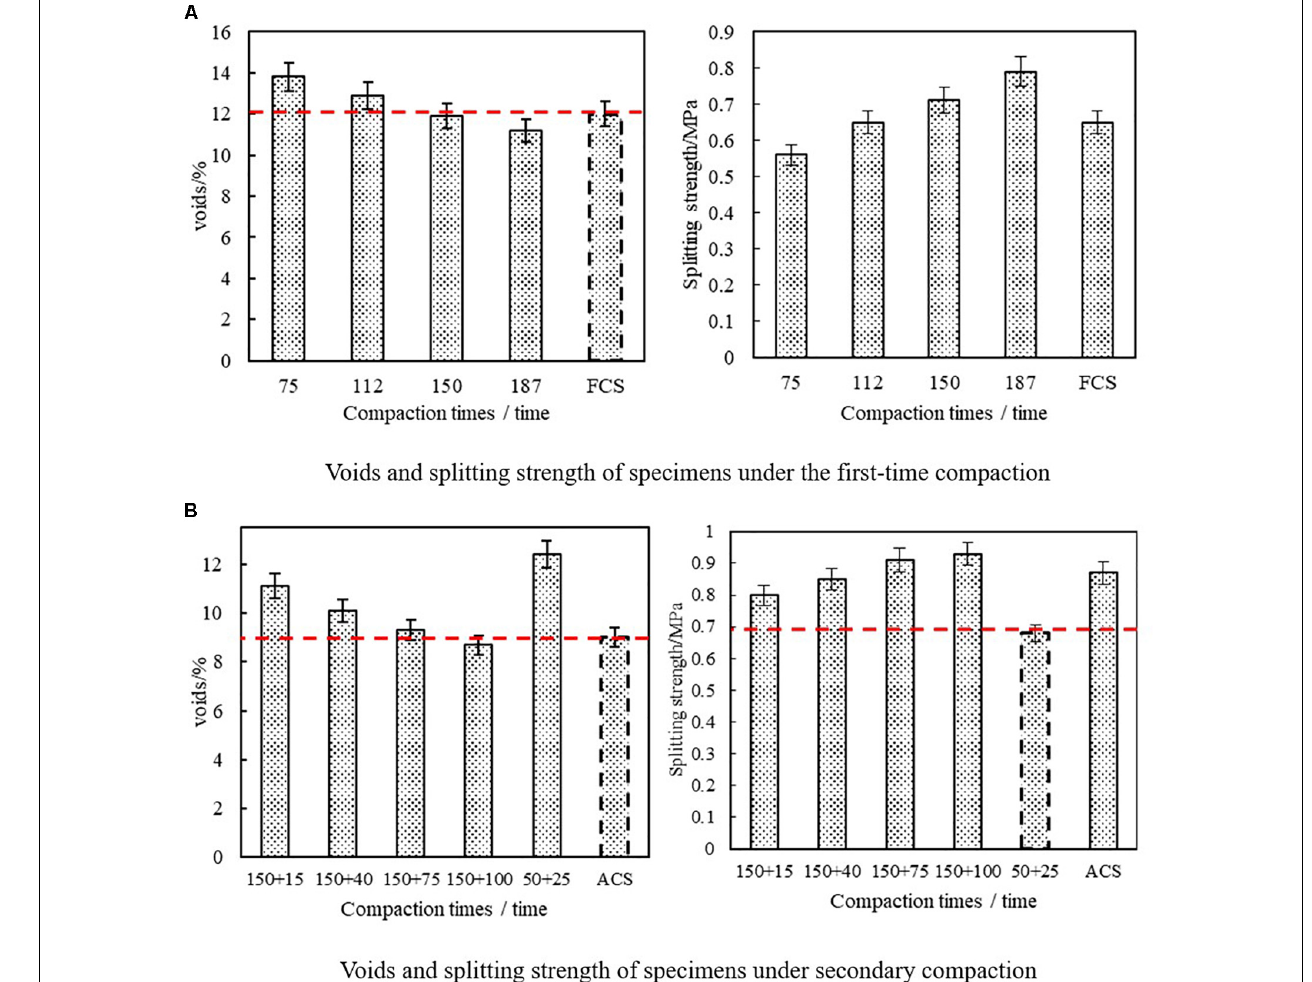
FIGURE 4 | Voids and splitting strength of large Marshall specimens under different compaction times: (A) voids and splitting strength of specimens under the first-time compaction; (B) voids and splitting strength of specimens under secondary